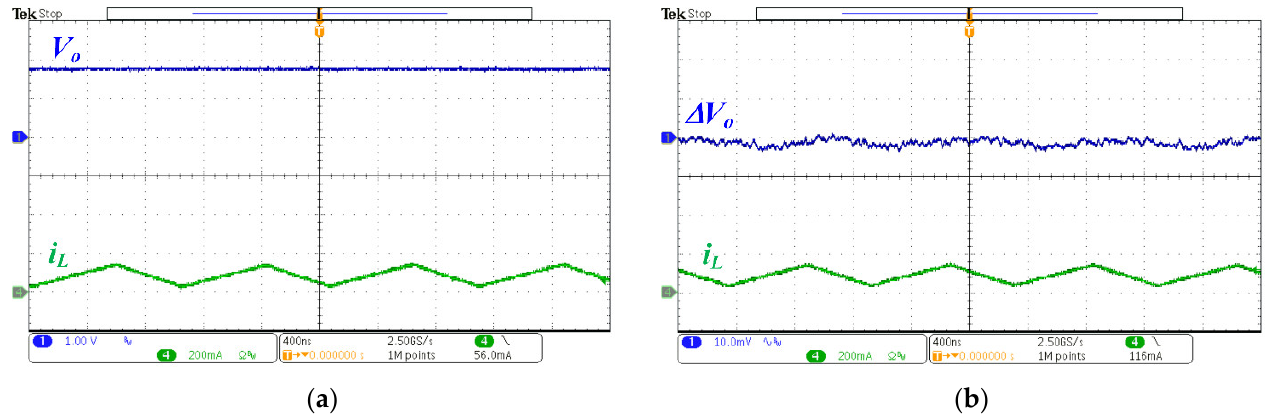
Figure 12. Measured waveforms with WTR control for ( a ) output voltage and ( b ) output voltage ripple at load current of 100 mA.